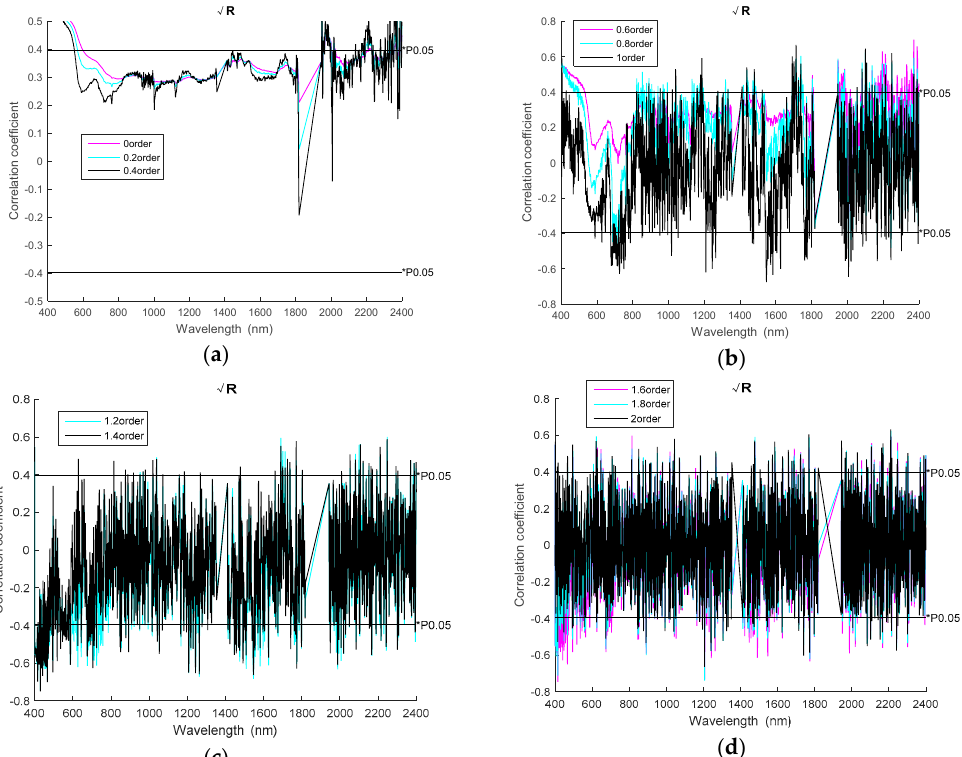
Figure 4. Trends of correlation coefficient for root mean square: ( a ) 0-order to 0.4-order; ( b ) 0.6-order to 1-order; ( c ) 1.2-order to 1.4-order; and ( d ) 1.6-order to 2-order.